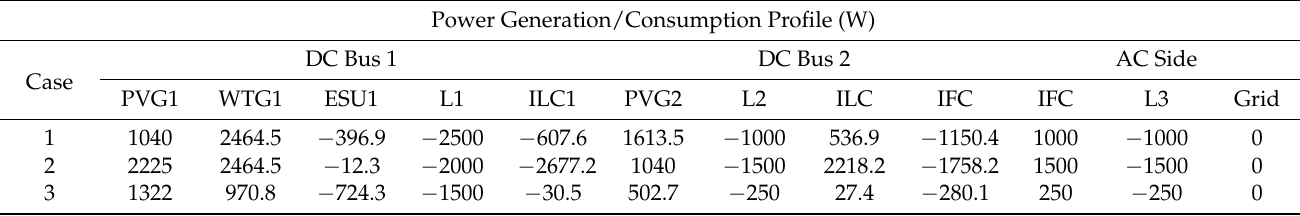
Table 12. Results for scenario 3 evaluated for the three selected